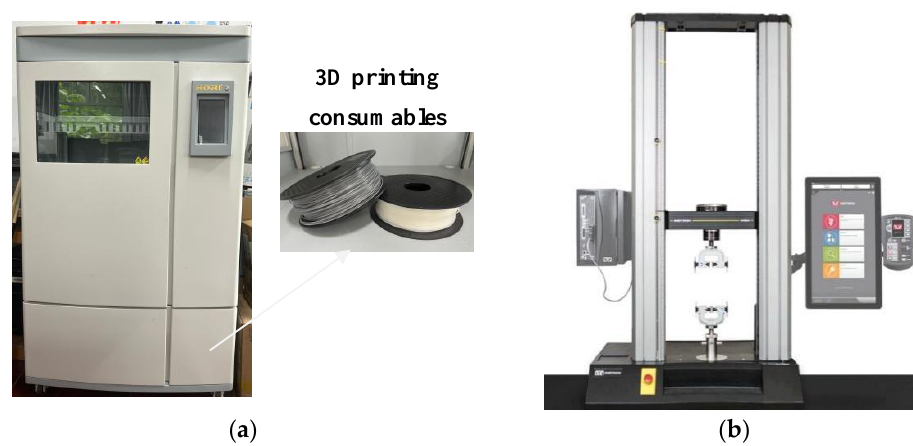
Figure 10. Experimental apparatus. ( a ) 3D printer; ( b ) Universal testing machine.